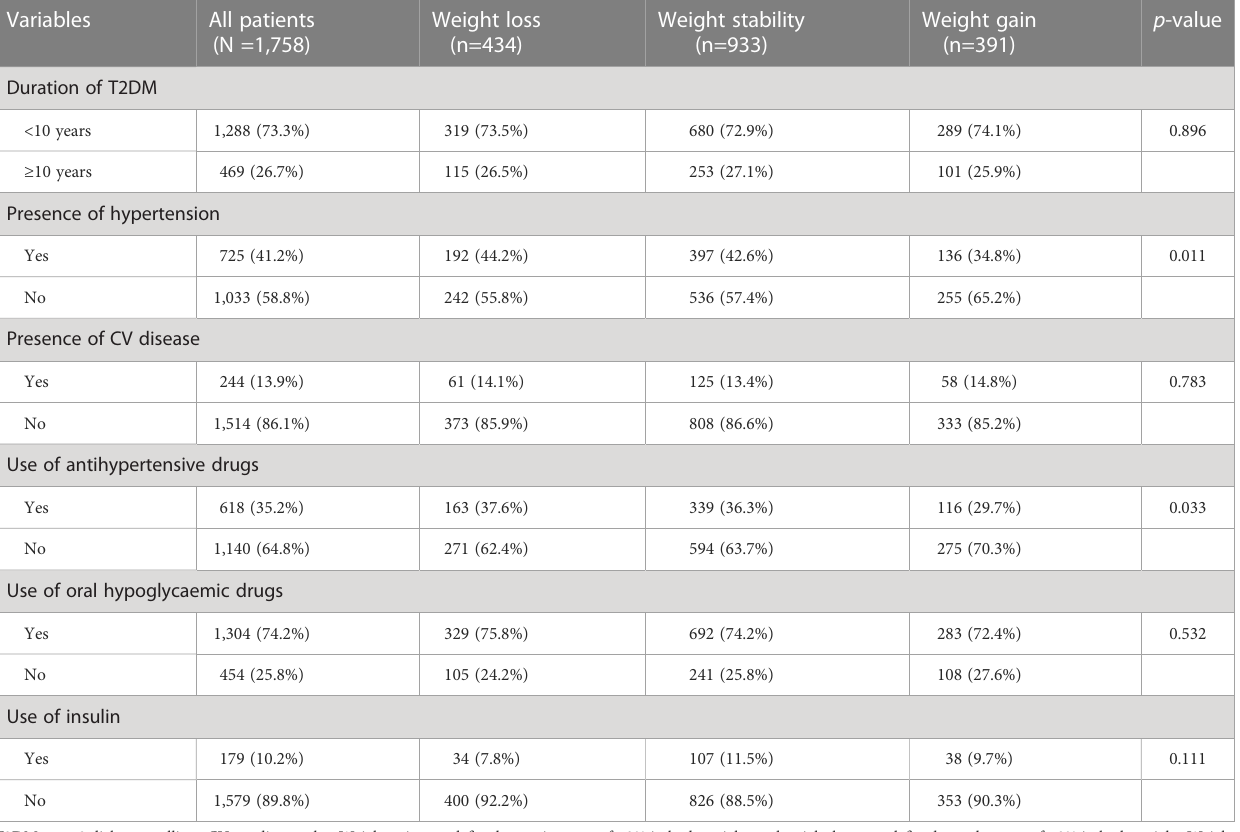
TABLE 2 Medical history and use of medications by different weight change